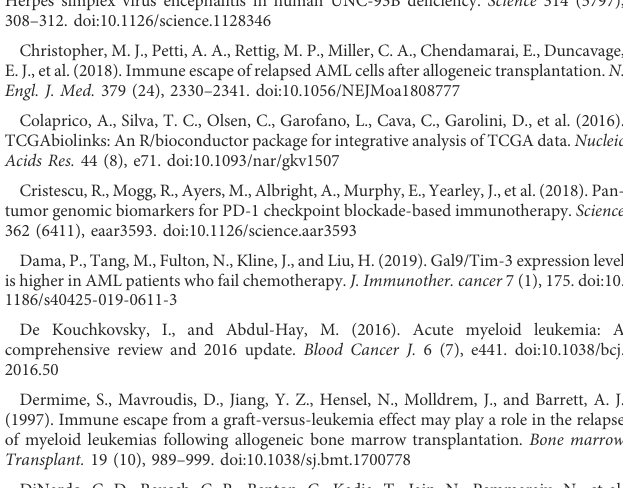
and UC993B1 -low AML.